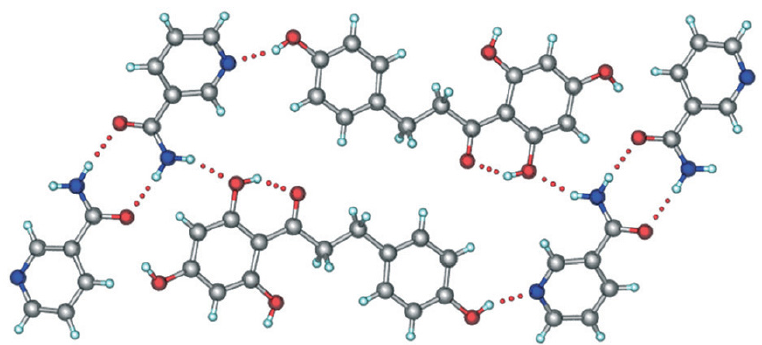
Figure 4. Packing diagram of the co-crystal of phloretin and nicotinamide (form I). Adapted with permission from Aitipamula et al. [85].